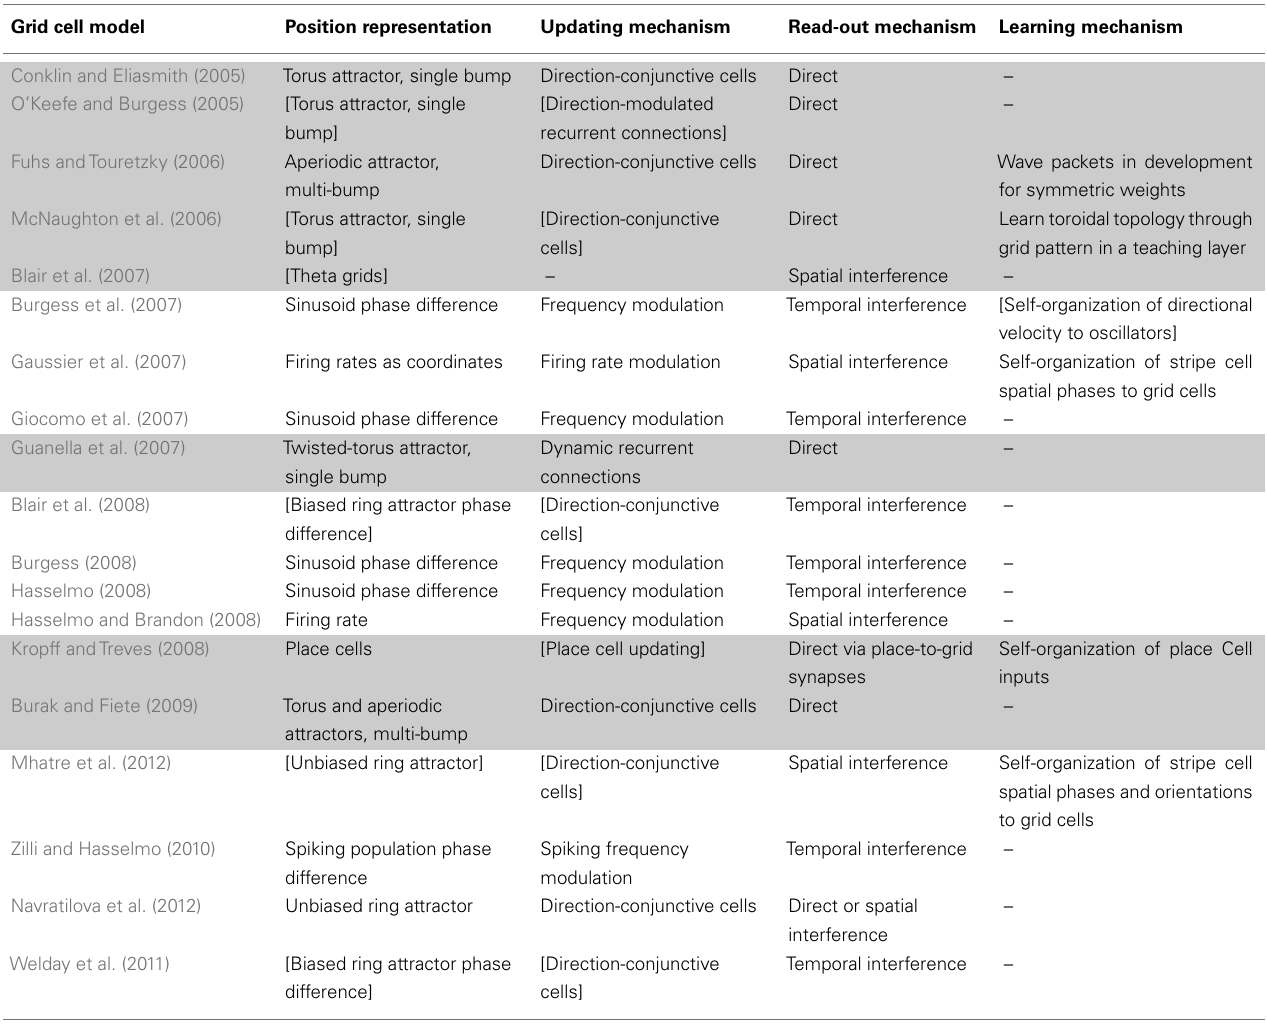
Table 1 |The models on Marr’s algorithmic